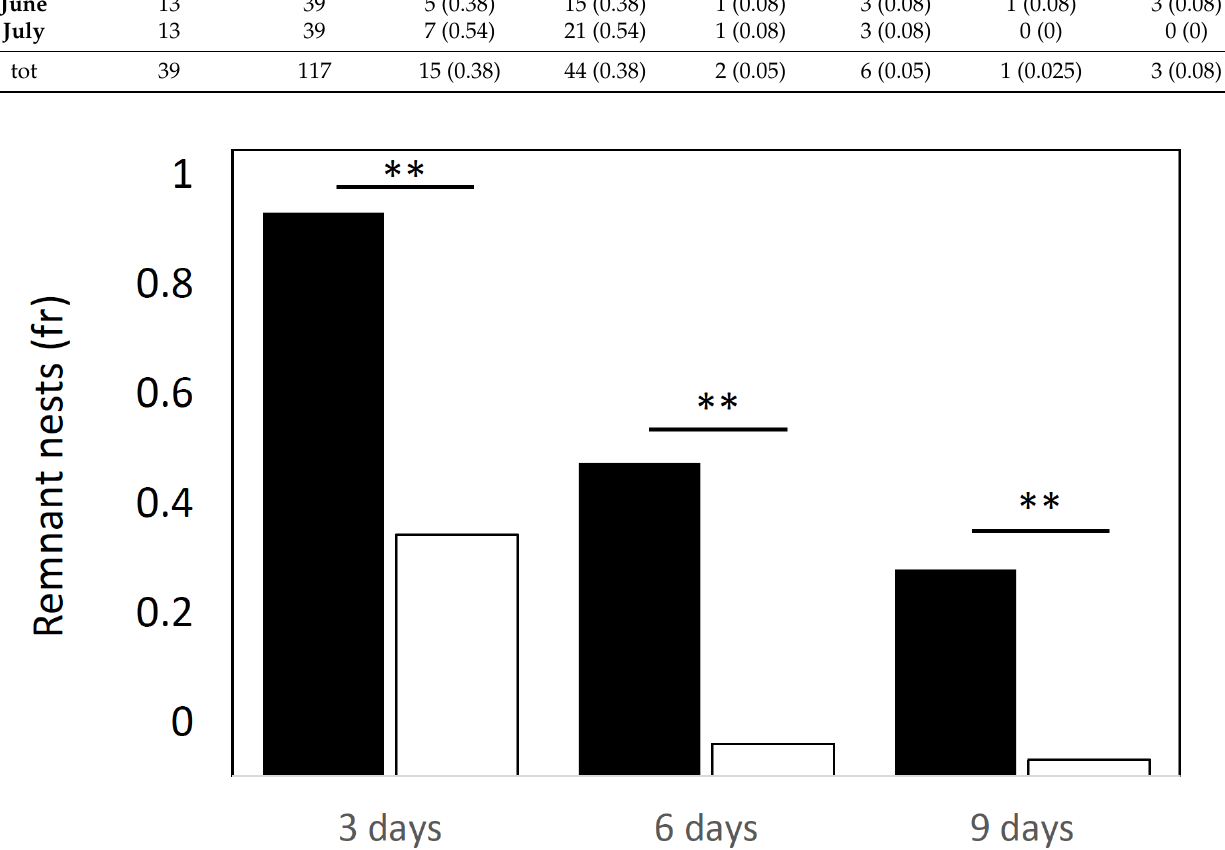
Figure 2. Cumulative percentage of quail eggs in false nests with (black columns) and without cage (white columns) at the I recording session (after three days), II (six days), III (nine days). **: p < 0.001. Overall, we recorded 59 events of nest predation. In experimental nests ( n = 21 events), the most frequently recorded predator was the fox, Vulpes vulpes ( n = 10; 47.6%;